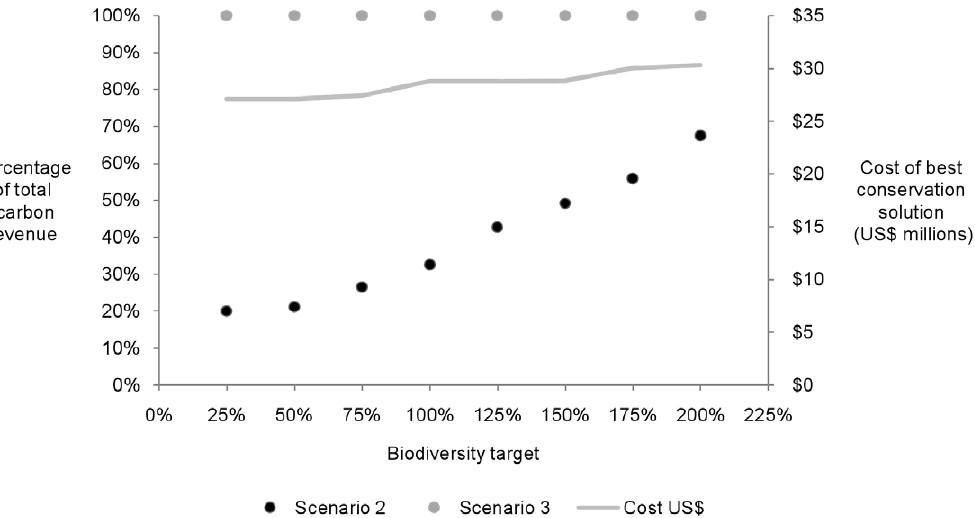
Figure 5. The total carbon potential of the stewardship arrangement was achieved for all biodiversity target levels when carbon biosequestration (tCO 2 -e) was specifically targeted (Scenario 3) and when a budget was fixed equivalent to the cost of Scenario 2 (where carbon revenue is deducted from the land stewardship cost) at the same biodiversity target level. The amount of incidental carbon captured within Scenario 2 rose with an increase of the biodiversity target and the cost.